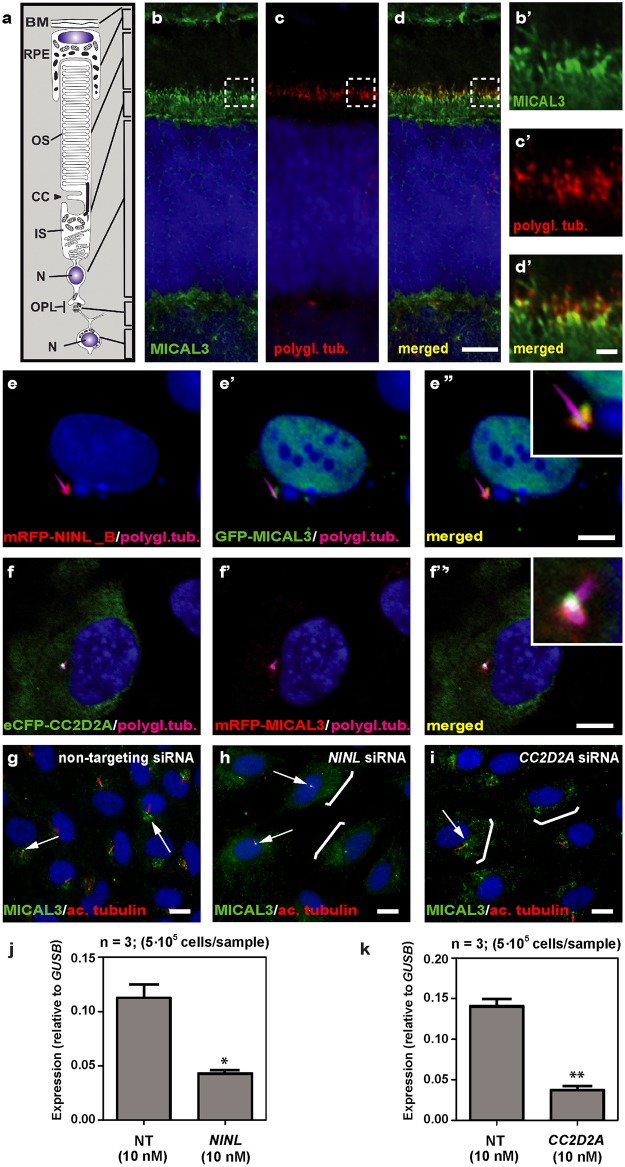
NINL and CC2D2A co-localize with MICAL3 and are required for correct MICAL3 localization.(a) Schematic of a photoreceptor for orientation. (b-d’) Co-localization of endogenous MICAL3 (green signal; b) and polyglutamylated tubulin (red signal; c) in rat retina (P20) by co-immunostaining radial cryo-sections. The yellow signal in the merged image (d’) indicates co-localization at the base of the photoreceptor connecting cilium. (b’-d’) are high magnification images of the boxed areas in (b-d). (e-f”) Centrosomal co-localization of NINLisoB, CC2D2A and MICAL3 in hTERT-RPE1 cells. mRFP-NINLisoB (red signal, e) localizes to the basal body of the cilia marked with polyglutamylated tubulin (cyanid signal; e) and overlaps with GFP-tagged MICAL3 (green signal, e’) at the ciliary base when co-expressed (yellow signal, e”). Co-expression of eCFP-CC2D2A (green signal, f) and mRFP-MICAL3 (red signal, f’) resulted in partial overlap at the base of the cilia (yellow signal, f”). (g) Endogenous MICAL3 (green signal) detected by immunostaining clusters at the ciliary base (white arrows; cilium marked with anti-acetylated tubulin in red) of hTERT-RPE1 cells treated with non-targeting siRNA. (h, i) Knockdown of NINL (h) or CC2D2A (i) expression by siRNA results in dispersed distribution of MICAL3 throughout the cell body (brackets) with retention of some MICAL3 puncta at the ciliary base (arrows). qPCR analysis of NINL (j) and CC2D2A (k) siRNA treated hTERT-RPE1 cells. Cells were transfected with 10nM siRNA and all qPCR data were normalized against GUSB levels. Bar and error bars refer to mean and standard deviation, respectively (n = 3, on two biologicial replicates). *: P<0.05; **: P<0.01 versus non targeting siRNA (NT) (student’s t-test). Nuclei are counter stained with DAPI in all panels (blue signal). Scale bars: are 5 μm in d, 1 μm in d’ and 10 μm in e-i.